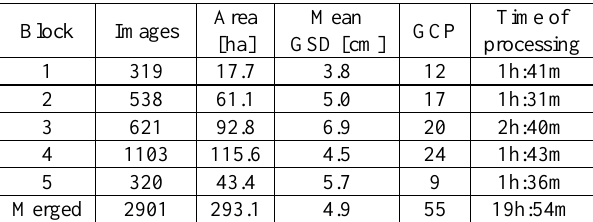
Table 1. Blocks characteristics for Kapilvastu site.